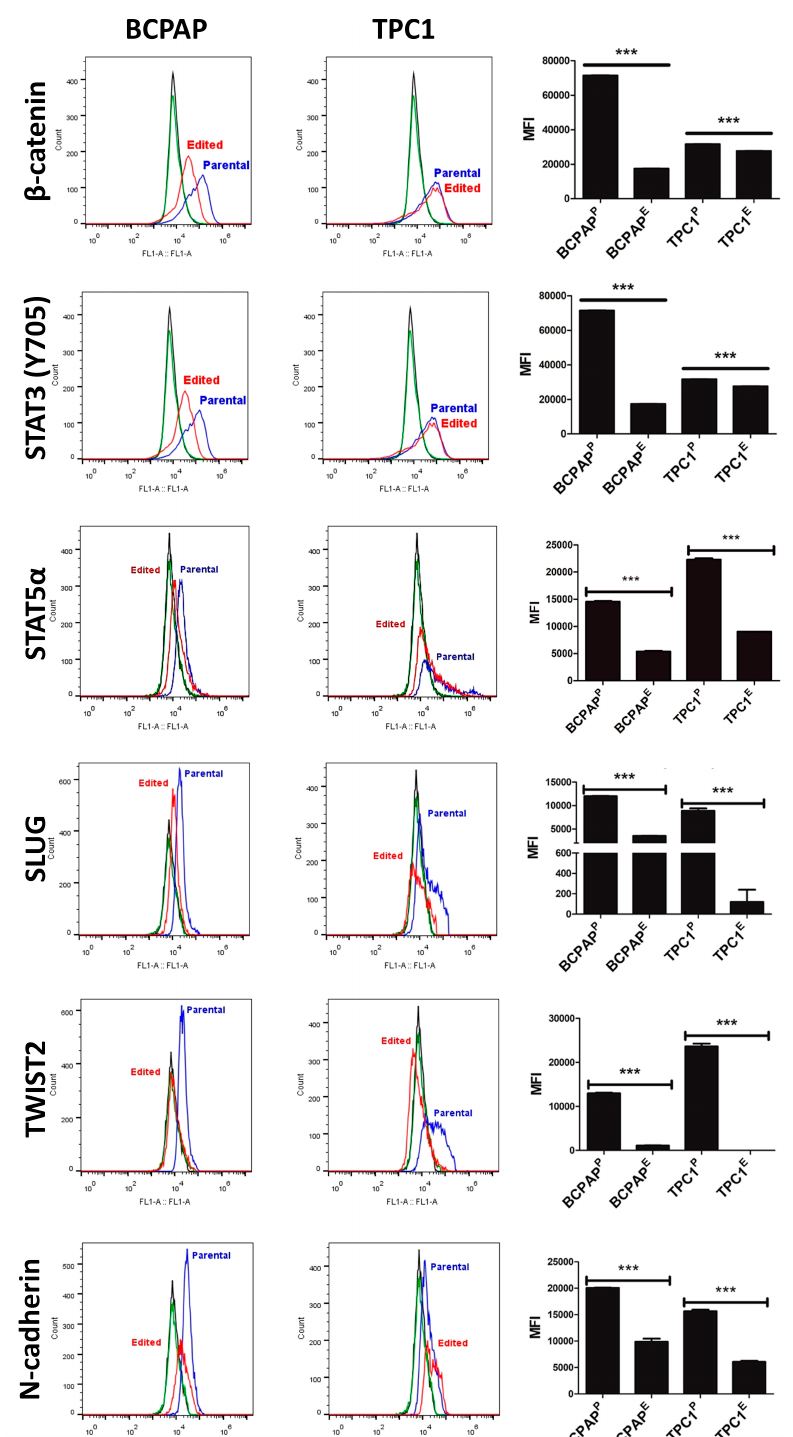
Figure 8. Results of immunodetection of β -catenin, STAT3 (Y705), STAT5 α , SLUG, TWIST2, and N-cadherin by flow cytometry. Results show a significant downregulation of all analyzed proteins in both edited cells. Flow cytometry analyses show cells not incubated with primary and secondary antibody (histogram in black), cells exclusively incubated with secondary antibody (histogram in green), and cells incubated with both primary and secondary antibodies (histogram in red). There were 10,000 events analyzed in duplicate. *** p < 0.001.